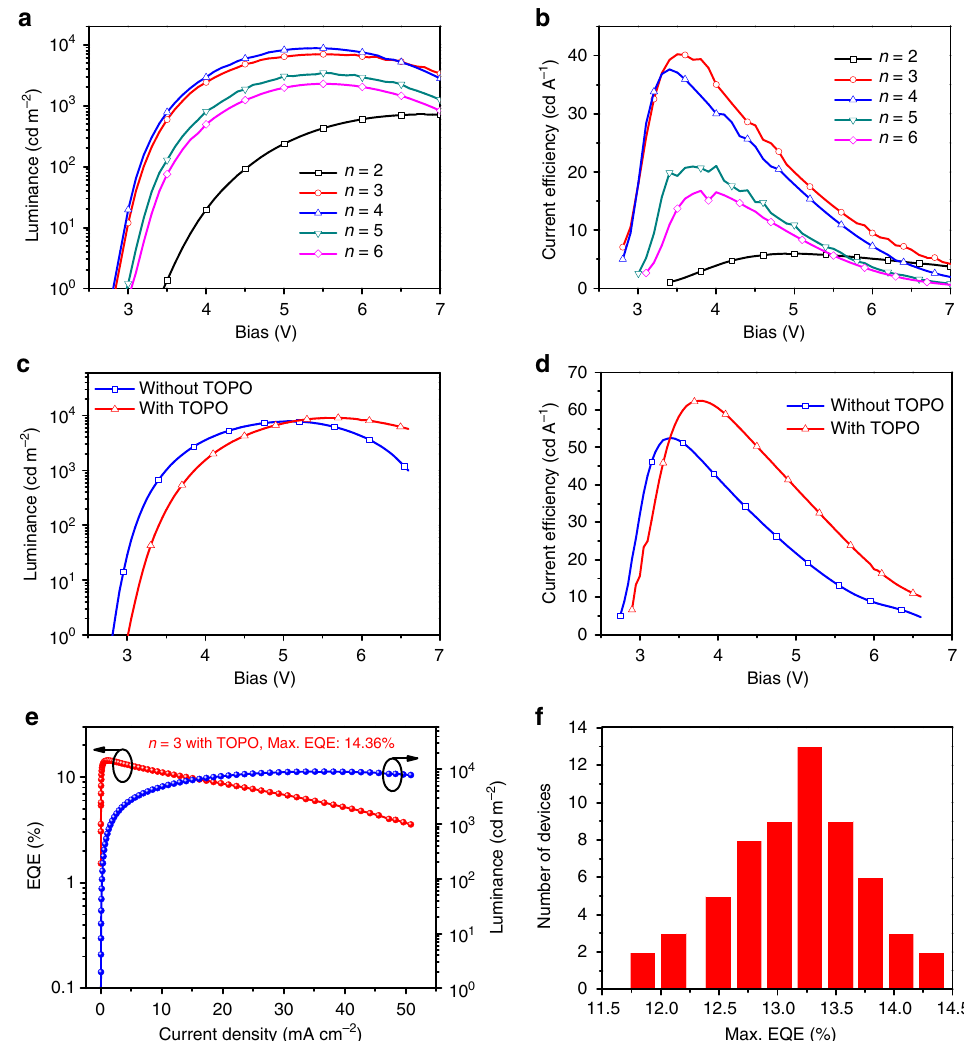
Fig. 4 Device performance of perovskite LEDs with different compositions and surface passivation. a Luminance – voltage (L-V) curves of PEA 2 (FAPbBr 3 ) n - fi ciency – voltage (CE-V) curves of PEA – voltage 1 PbBr 4 with different compositions. b Current ef 2 (FAPbBr 3 ) n -1 PbBr 4 with different compositions. c Luminance (L-V) curves of PEA 2 (FAPbBr 3 ) n -1 PbBr 4 ( n = 3 composition) devices with and without TOPO layer. d Current ef fi ciency – voltage (CE-V) curves of